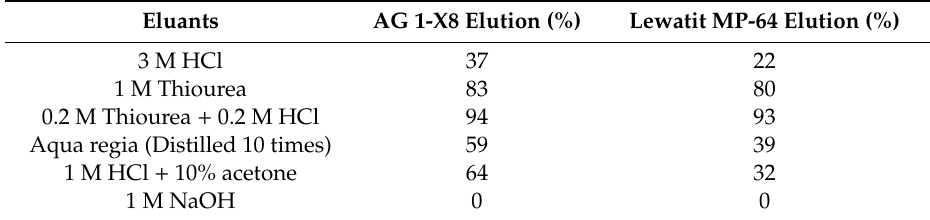
Table 2. Elution percentage of Ru(III) from the adsorbed AG 1-X8 and Lewatit